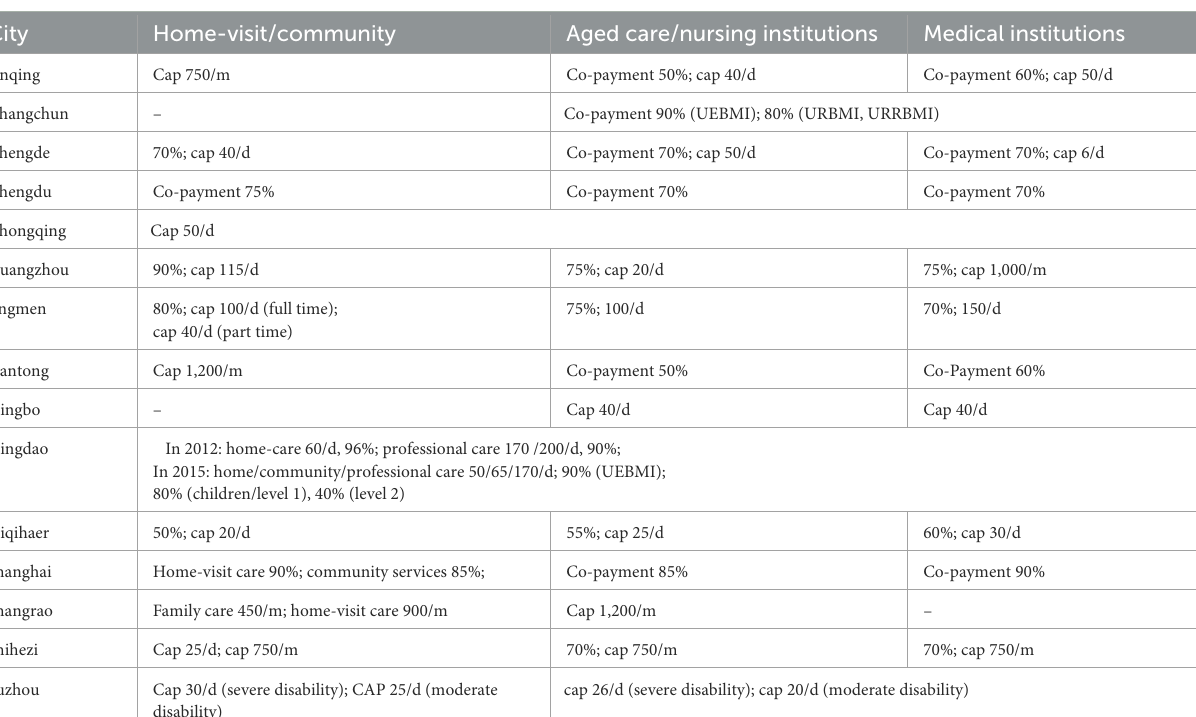
TABLE 2 Care services and benefits package of 15 pilot